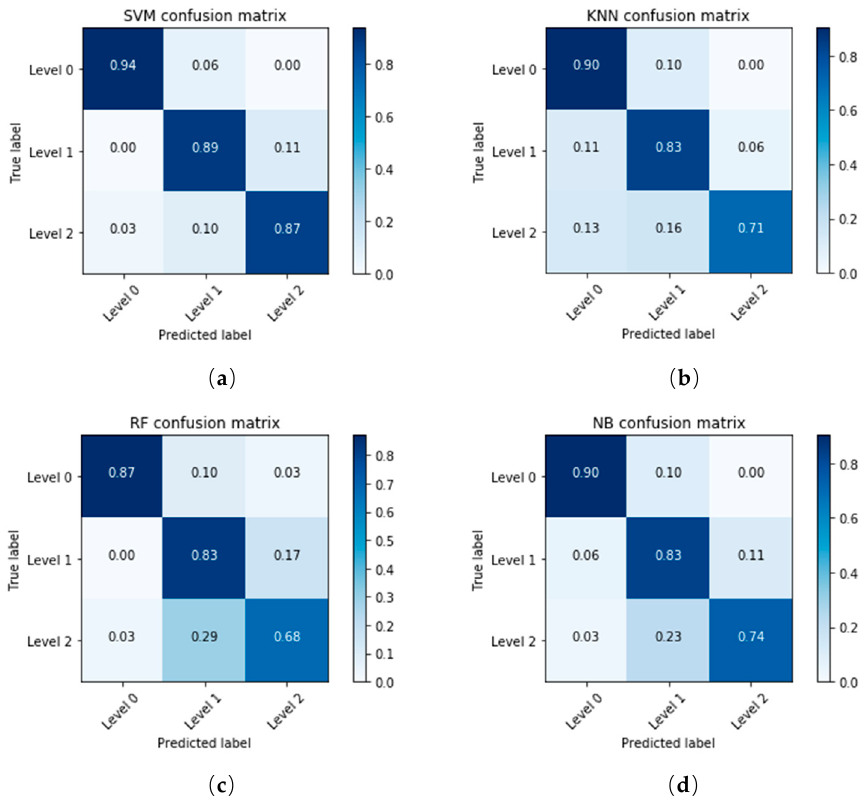
Figure 9. The confusion matrices of SVM, KNN, RF and NB models using the fused dataset.